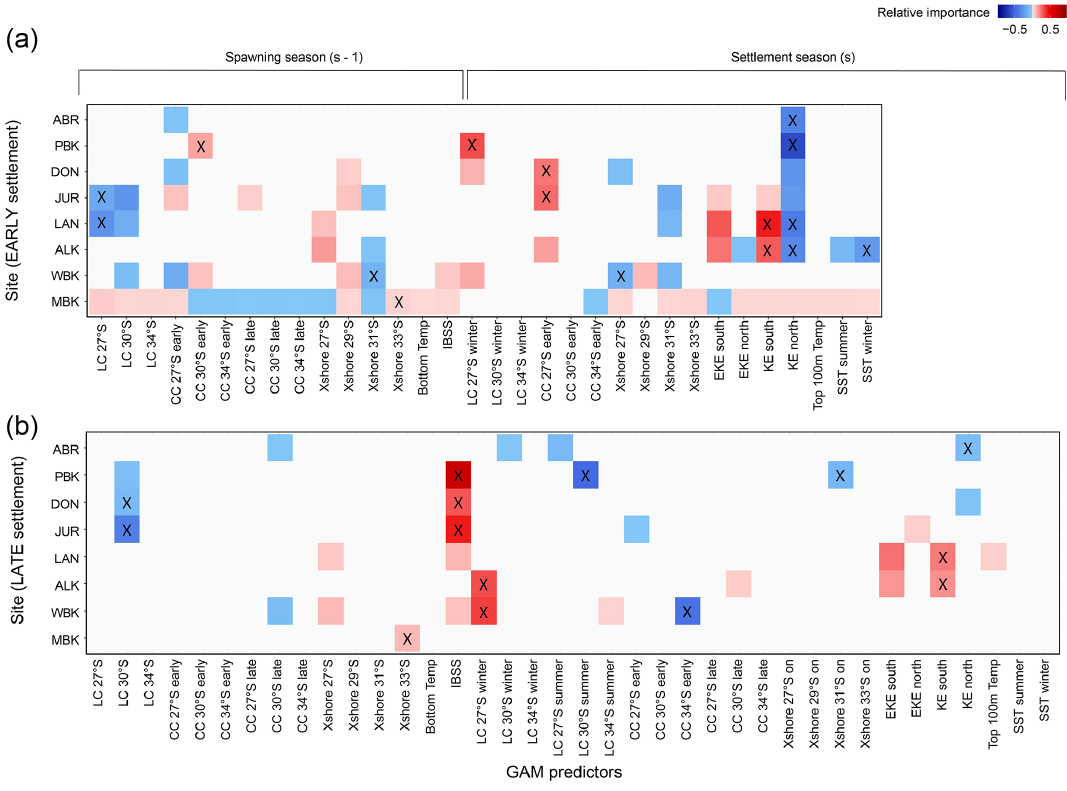
Figure 9. Variable importance scores within 2 AIC of the top model from the multiple linear regression analysis (GAM) to predict the (a) early and (b) late settlement at sites. Full results are in Appendix Tables B1 (early) and B2 (late). The timeline (above) indicates the timing of the variables from either the spawning season (s − 1) where larvae are moving offshore (westward) or the settlement season (s) where larvae are moving eastward. Positive (red), zero (white), and negative (blue) relationships with variables are shown, and variables within the most parsimonious model for each site are indicated (X).